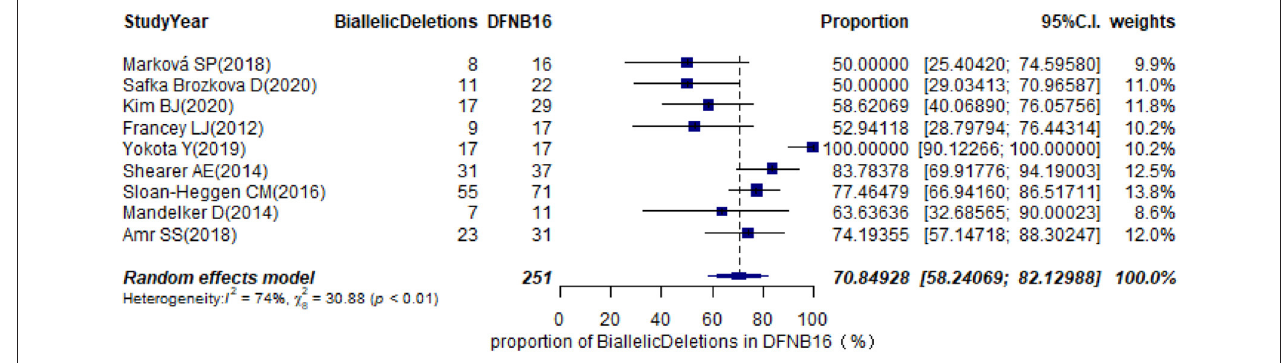
FIGURE 8 | Prevalence of biallelic deletions in